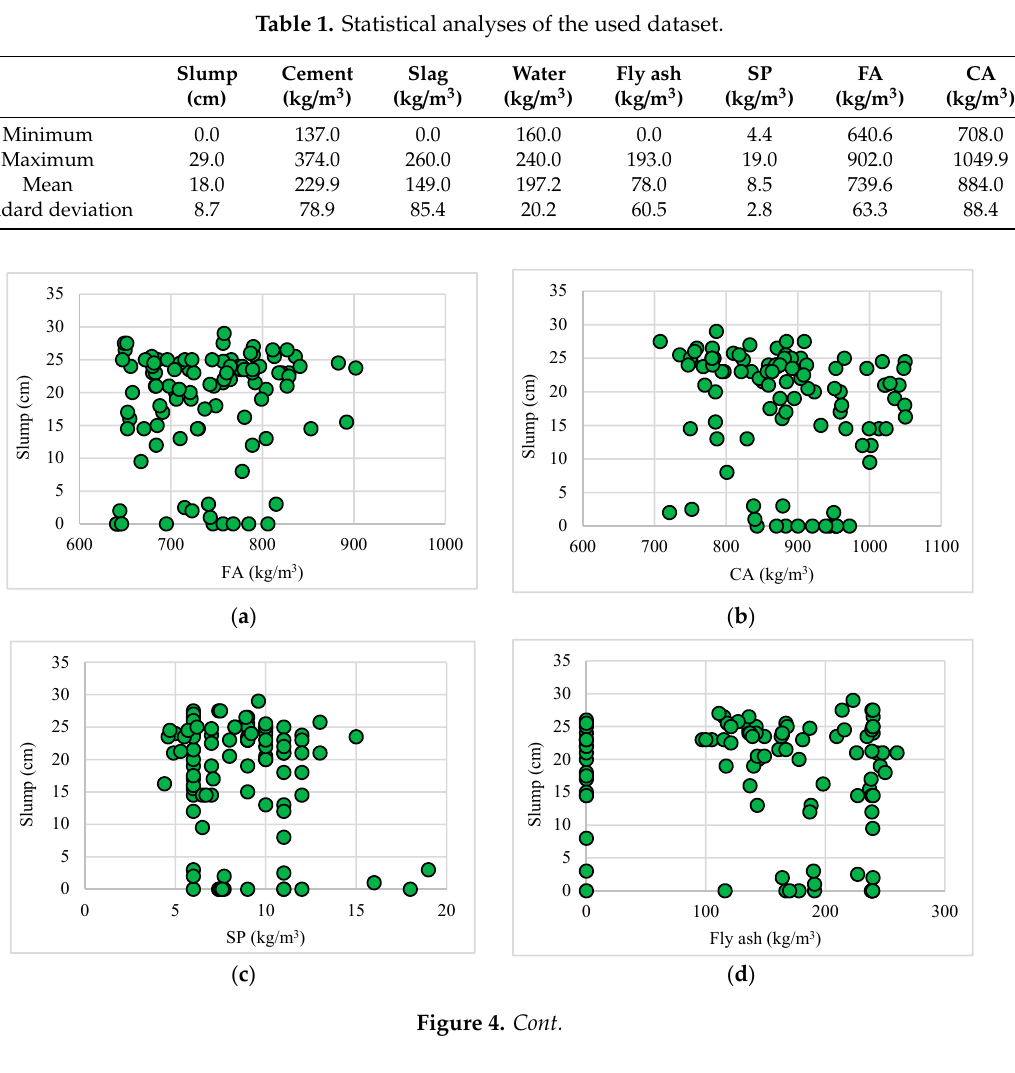
Table 1. Statistical analyses of the used